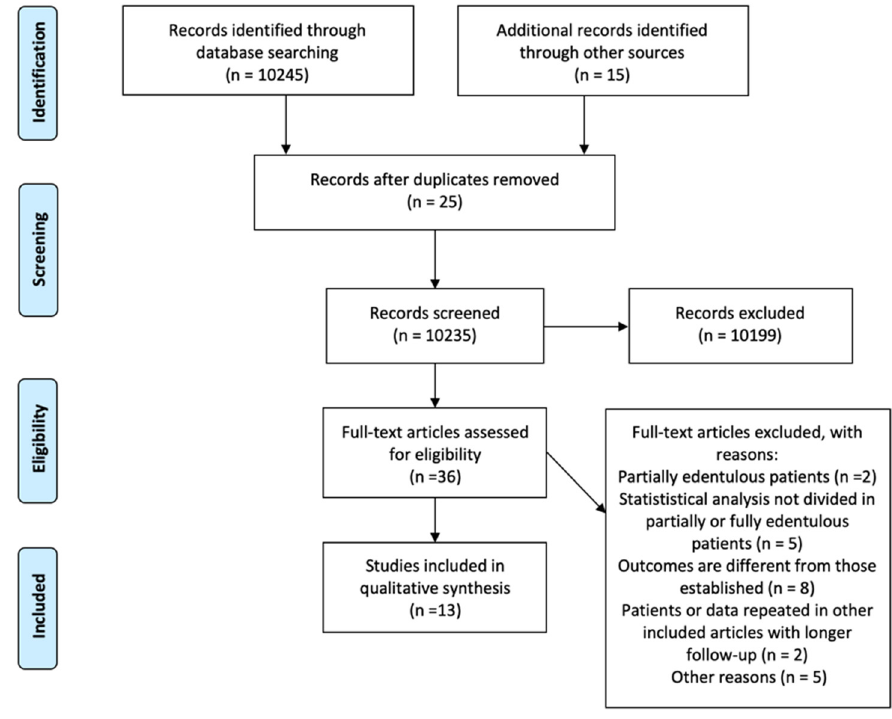
Figure 2. PRISMA flowchart.